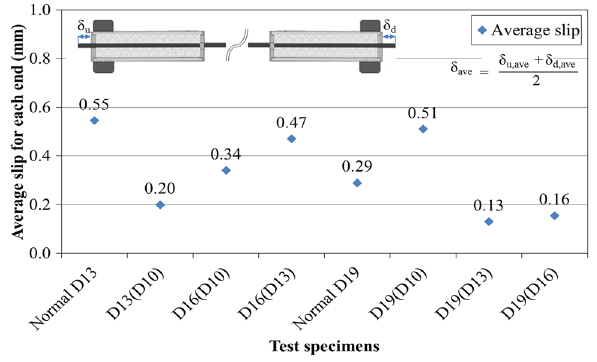
Fig. 5 Average slip measurement at both